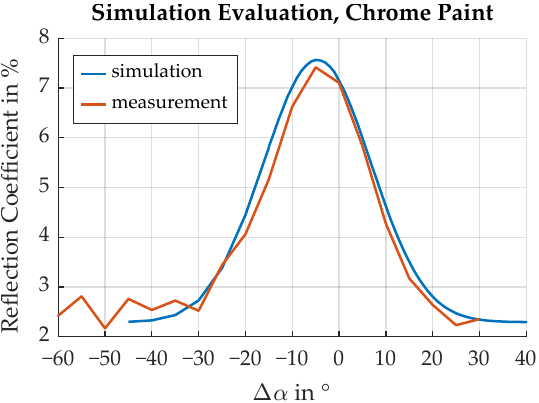
Figure 9. Comparison of the measured surface reflection with the simulated results for chrome paint. Incidence angle φ = 45°, emergent angle α = 45°.